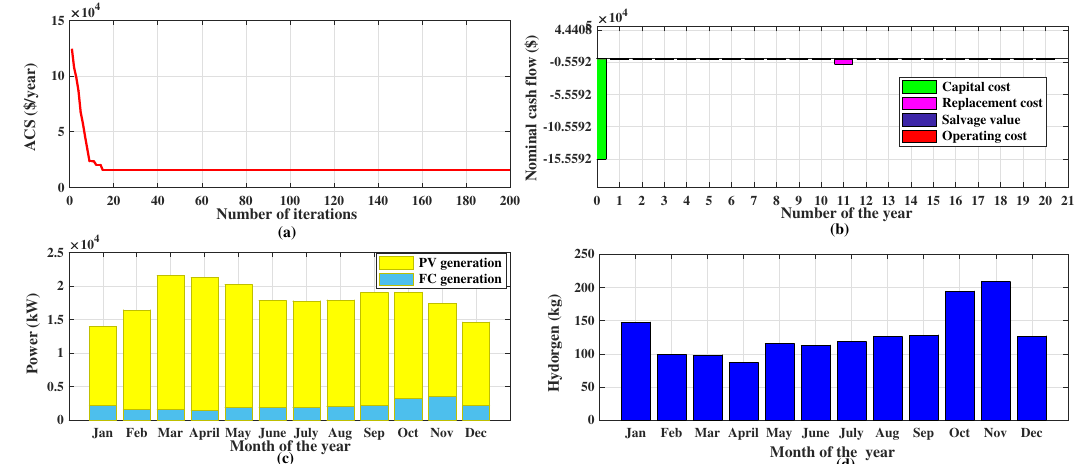
Figure 4. ( a ) Convergence characteristics of the ABC algorithm; ( b ) nominal cash flow throughout the project life; ( c ) monthly photovoltaic (PV) and fuel cell (FC) power generation; ( d ) monthly hydrogen produced by the electrolyzer.